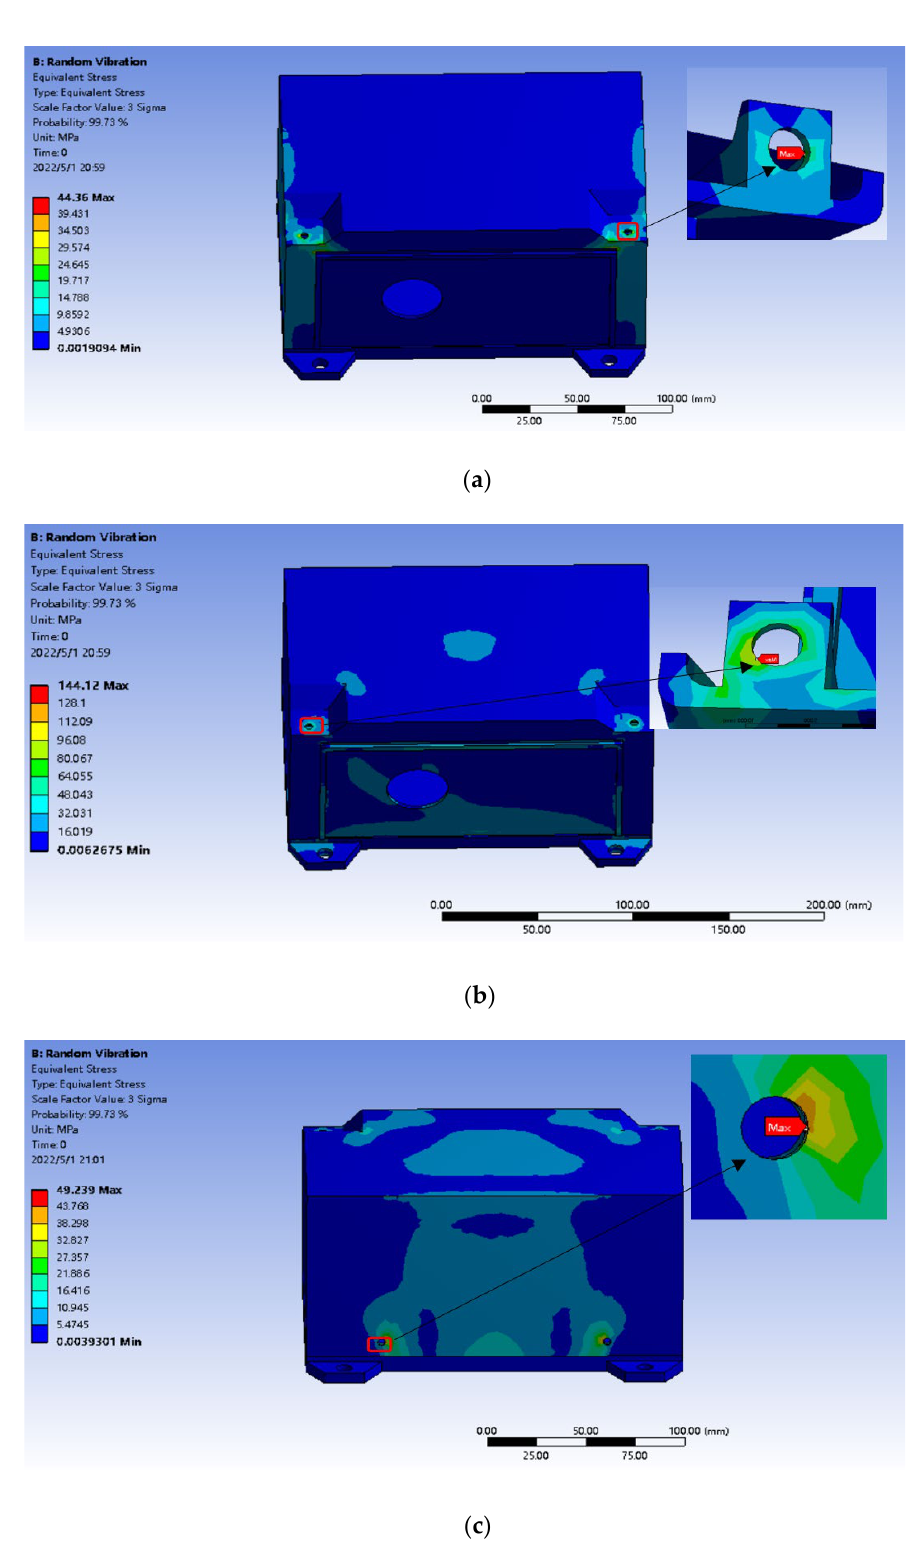
Figure 13. Stress in the X, Y, and Z directions and local hazard points: ( a ) stress and local hazard point in the X direction; ( b ) stress and local hazard point in the Y direction; ( c ) stress and local hazard point in the Z direction.